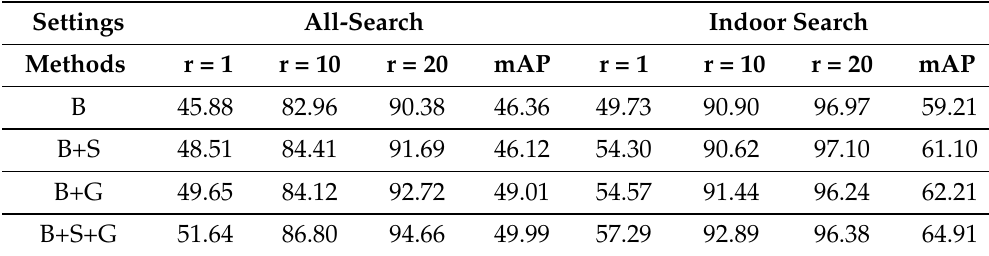
Table 3. SYSU ablation experiment